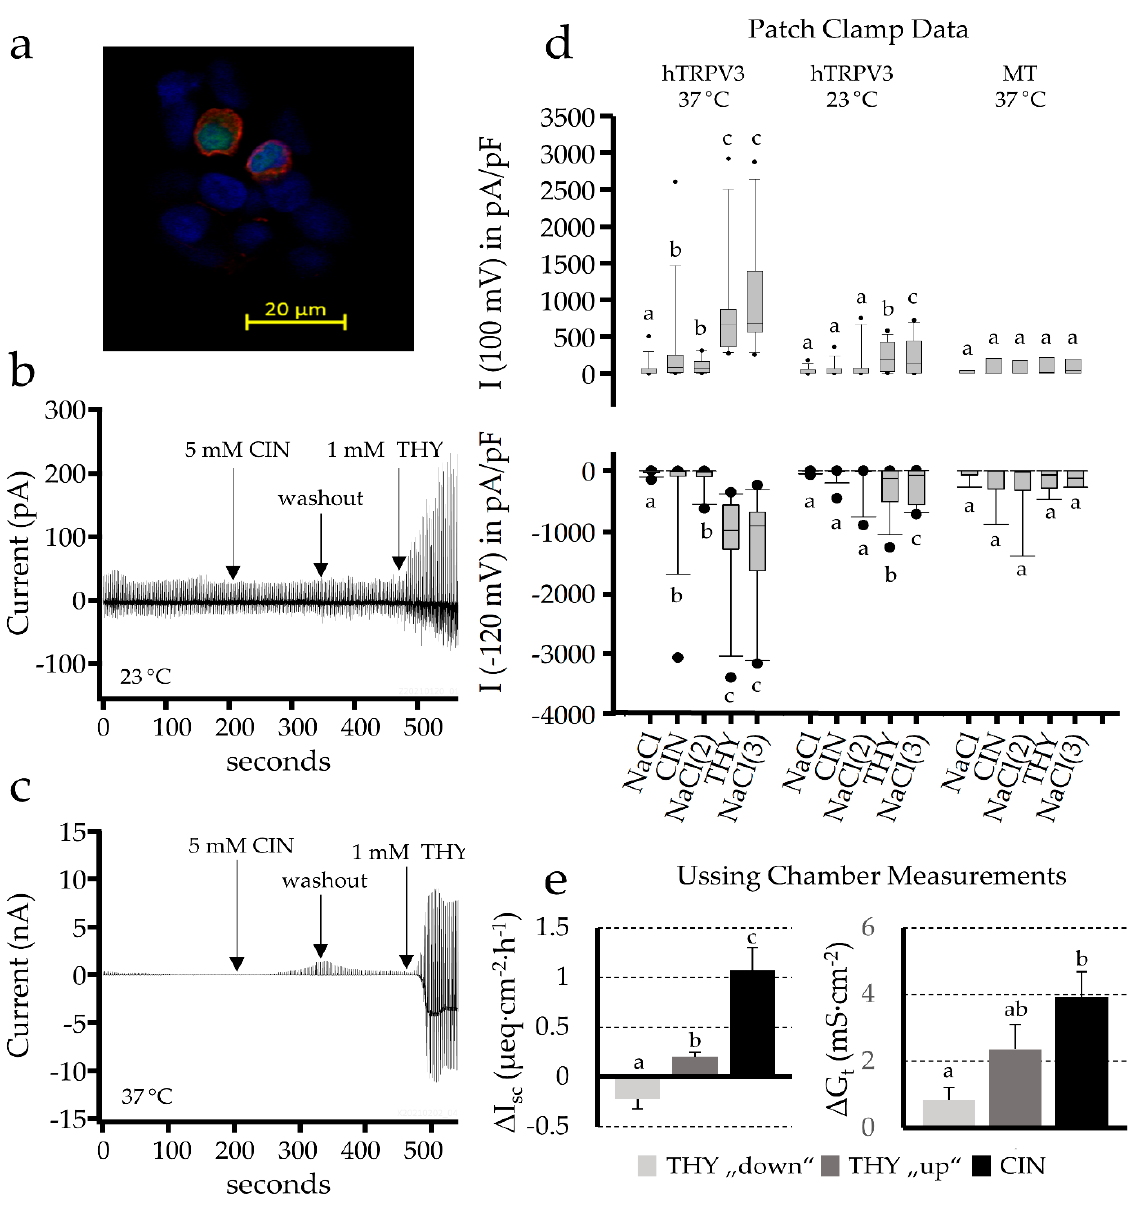
Figure 6. ( a ) Immunohistochemical staining of HEK-293 cells transfected with a vector for the simultaneous overexpression of human TRPV3 and green fluorescent protein (GFP, green), stained with a specific antibody against TRPV3 (red). The cell nuclei were stained with DAPI (blue). ( b ) An original recording of a patch clamp measurement of an hTRPV3 HEK-293 cell at 23 ◦ C. No visible response was seen after the addition of 5 mmol · L − 1 cinnamaldehyde (CIN), whereas 1 mmol · L − 1 thymol (THY) elicited a clear response. ( c ) A patch clamp measurement of an hTRPV3 HEK-293 cell at 37 ◦ C. The concentration of cinnamaldehyde had to be elevated to 5 mmol · L − 1 before a small response could be observed. In contrast, at 1 mmol · L − 1 , the effects of the thymol were very strong. ( d ) A boxplot of patch clamp data from hTRPV3 HEK-293 cells at 37 ◦ C and 23 ◦ C, and from control cells transfected with the empty vector (MT, 37 ◦ C) at +100 mV and − 120 mV. Within a group, significant differences after the addition of cinnamaldehyde or thymol and the subsequent washouts (NaCl(2) and NaCl(3)) are indicated via different letters above the bars. Comparisons between the groups are given in the main text ( e ) Data from Ussing chamber experiments from a subset of seven young pigs from Figure 5 (controlled in-house study), treated in parallel with either thymol (N/n = 7/13) or cinnamaldehyde (N/n = 7/14). In the native colonic tissues, 1 mmol · L − 1 of cinnamaldehyde was sufficient to induce a clear change in the short circuit current and the conductance, which rose by − 1 ) are also shown. Here, the I ∆ I ∆ G sc and t , respectively. For comparison, the data for thymol (1 mmol · L sc responses were clearly smaller, but diverse, with some tissues showing an increase in I sc (“up”, N/n = 4/7) and others a decrease (“down”, N/n = 4/6). Bars that do not share a letter are significantly